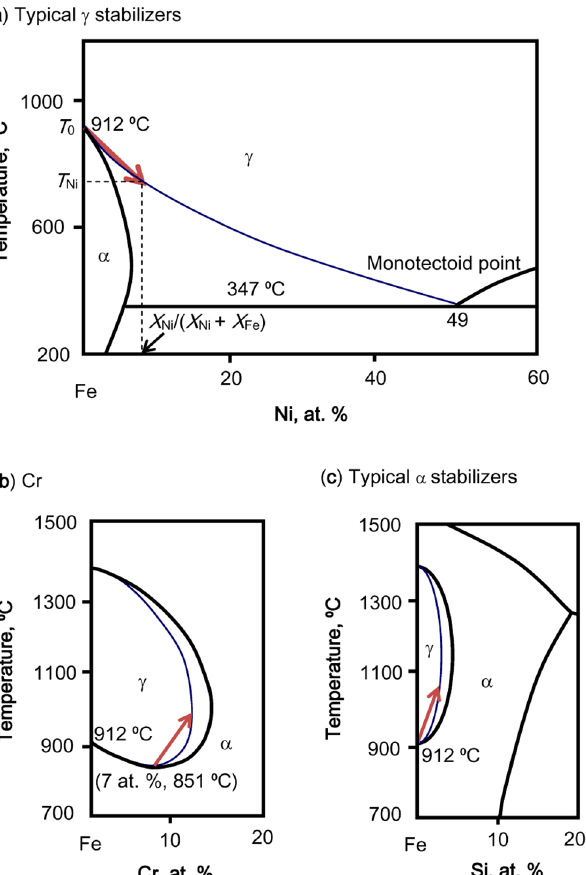
Figure 2. Fe-rich sides of binary phase diagrams of Fe–Ni ( a ), Fe–Cr ( b ), and Fe-Si ( c ), showing the γ decomposition boundaries (blue lines) and the slope of the lower boundary of γ phase zone (red